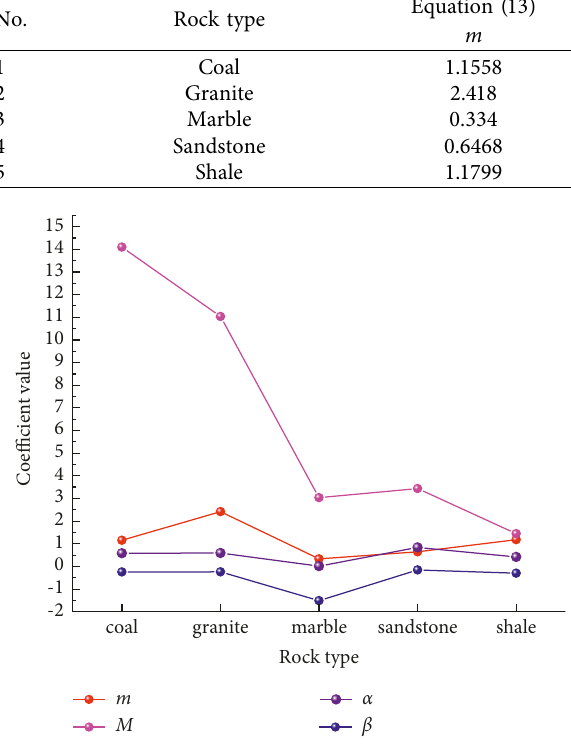
Figure 7: Variation of values of parameters in different